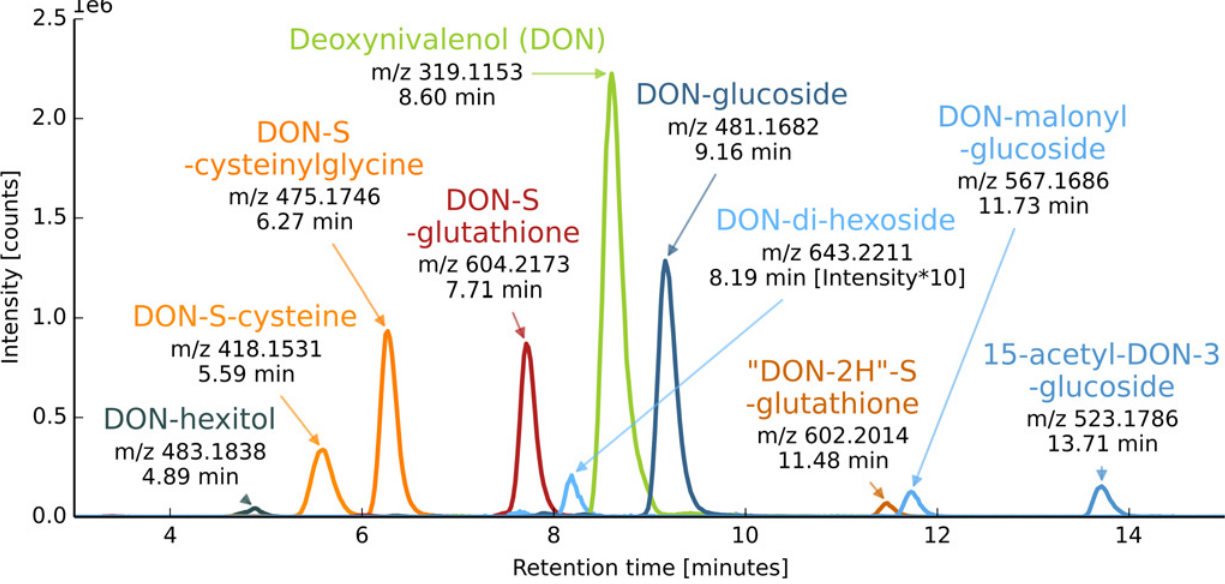
Fig 1. EICs of DON and its corresponding biotransformation products. EICs of accurate mass traces ( ± 3 ppm) of DON and its corresponding biotransformation products in a wheat sample harvested 96 hours post treatment with 1 mg DON. Due to low abundance, EIC intensities of DON-di-hexoside were multiplied by a factor of